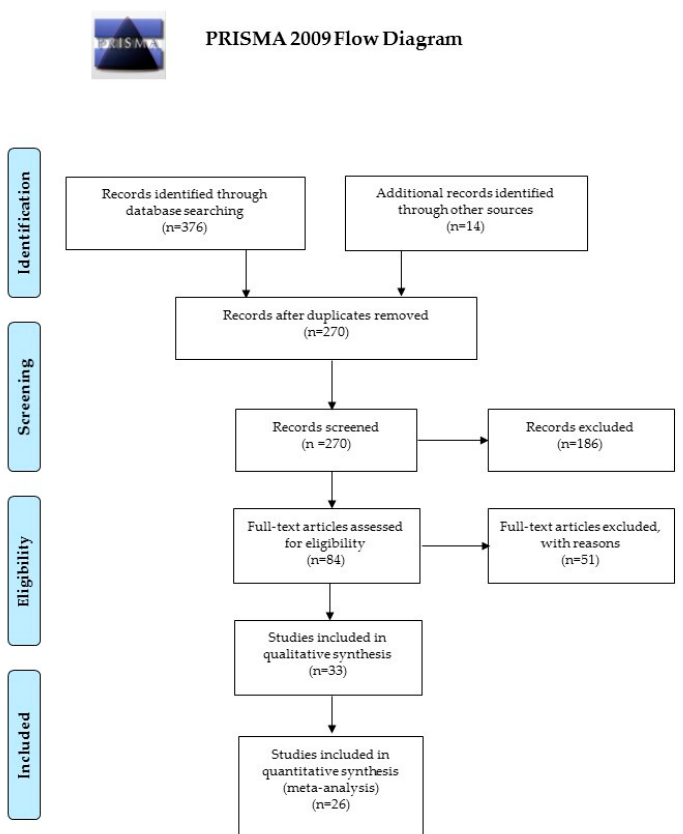
Figure 1. Flowchart of study selection, inclusion and synthesis. Table 2. Characteristics of studies included.